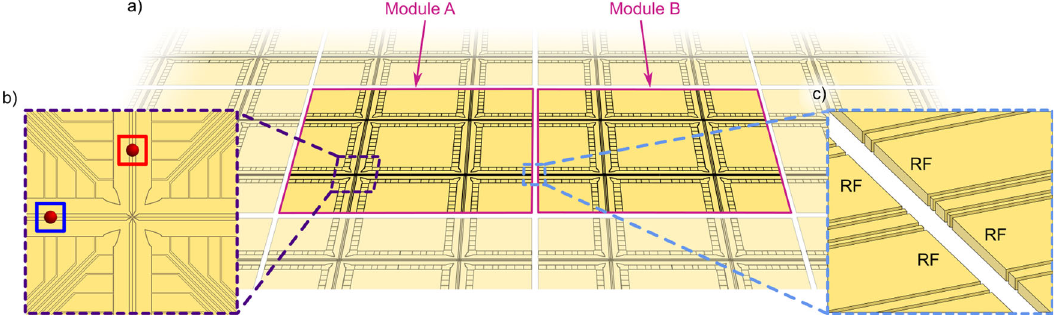
certain functions and are connected by mobile ions. For instance, a qubit may be locatedinagatezoneforquantumlogicoperations(bluebox)whileanotherqubit may be stored in, or moved to, a memory zone (red box). Inset c ) depicts the gap separating the modules. Distinct RF electrode pairs extend out to the edge of the modulestocreatearadiallycon fi ningpotentialsuchthationscanbetransportedto the neighbouring module.